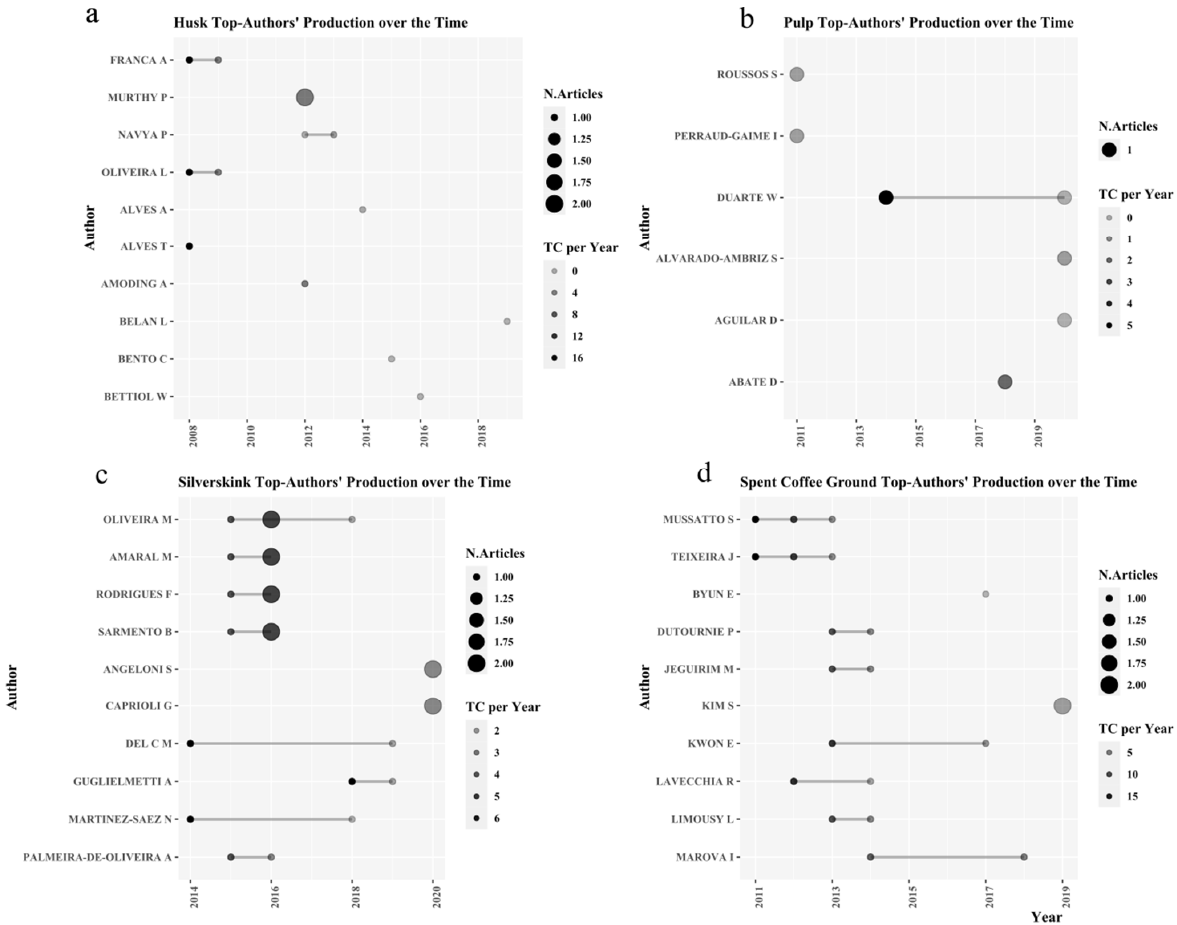
Figure 3. Author production per coffee by-product application over time for: ( a ) CH, ( b ) CP, ( c ) CS, ( d ) SCG.